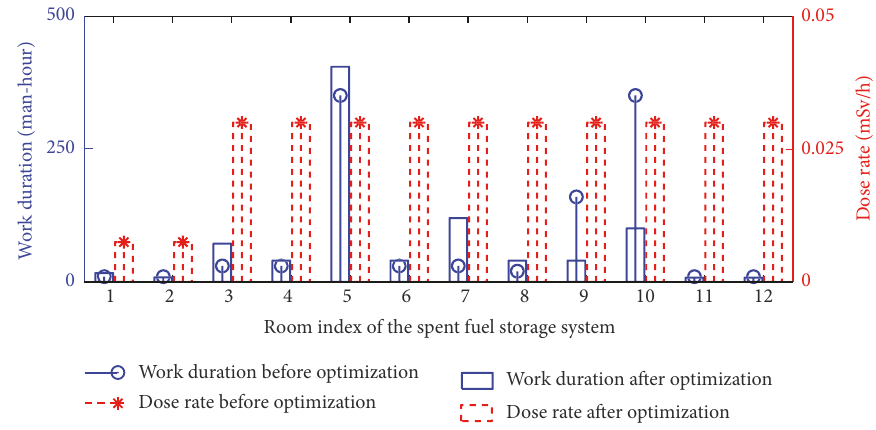
Figure 10: Dose rates and work durations of rooms of the spent fuel storage